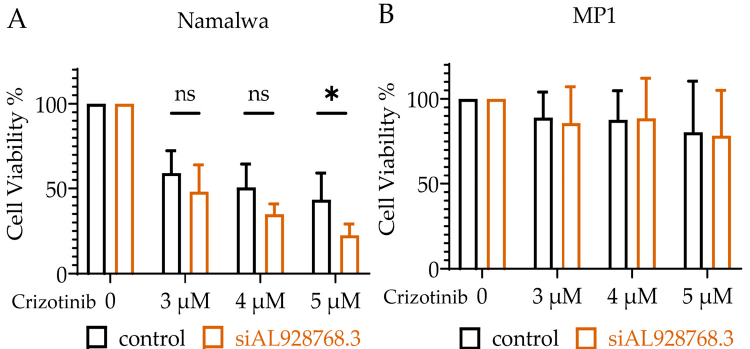
Figure 6. Cell viability under Crizotinib with the knockdown of AL928768.3. Number of viable Namalwa (n = 4) ( A ) and MP1 (n = 4) ( B ) cells after treatment with 3 µ M, 4 µ M and 5 µ M of Crizotinib. Measurements were taken on day 5th. Normalization was performed on the same sample without the drug. ScRNA was used as a control. * p -value less than 0.05, ns—no significant difference (Student’s t -test). The results of 4 independent experiments are shown.